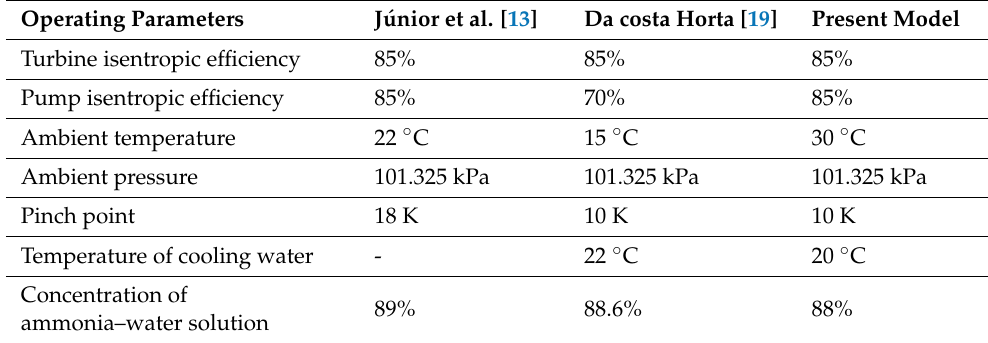
Table 12. Inlet data for validation.